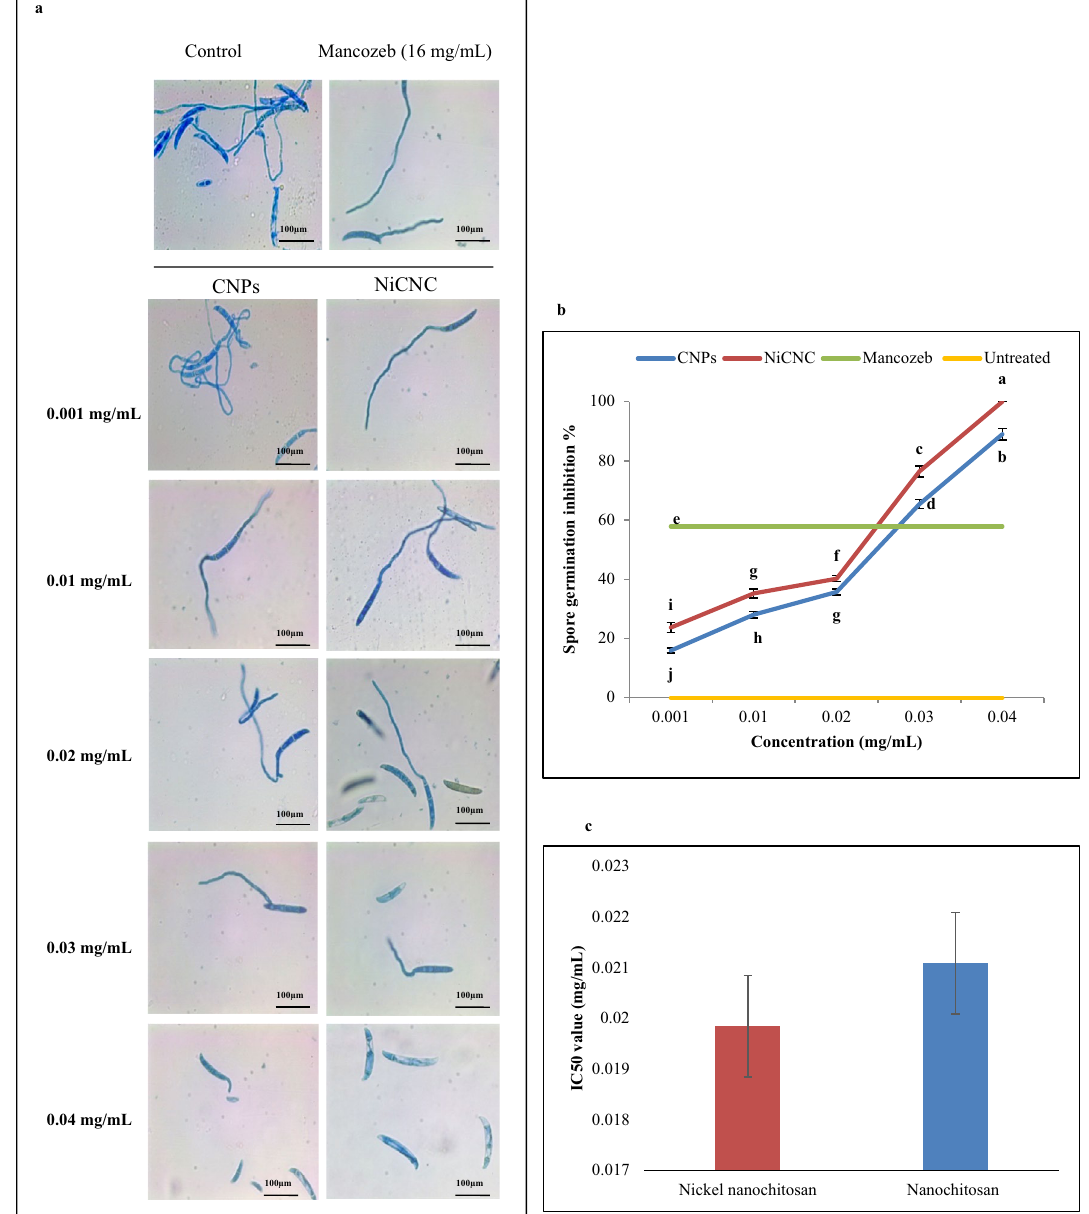
Figure 3. Effect of CNPs and NiCNC on inhibition percentage of spore germination of F. solani . ( a ) Microscopic images of spore germination inhibition of F. solani with different concentrations (0.001–0.04 mg/ mL) of CNPs and NiCNC in comparison with Mancozeb (16 mg/mL) and untreated (control) spores (Magnification = 400×); ( b ) spore germination inhibition percentage of F. solani . Data are expressed as the mean ± SD (n = 3), different letters indicate significant difference between the treatments at p ≤ 0.05; ( c ) IC50 values of CNPs and